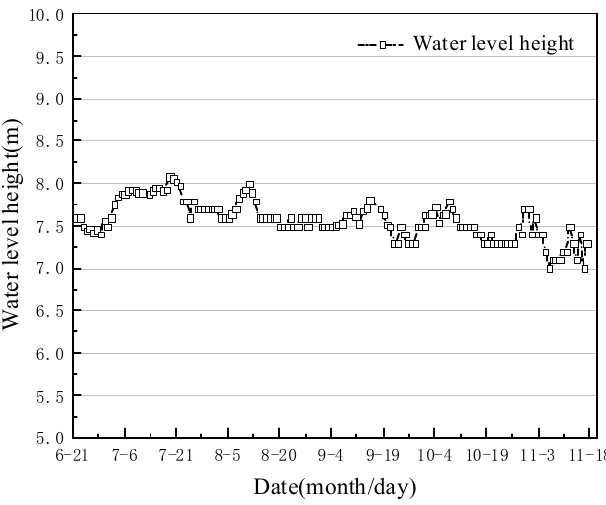
Figure 12. Groundwater level